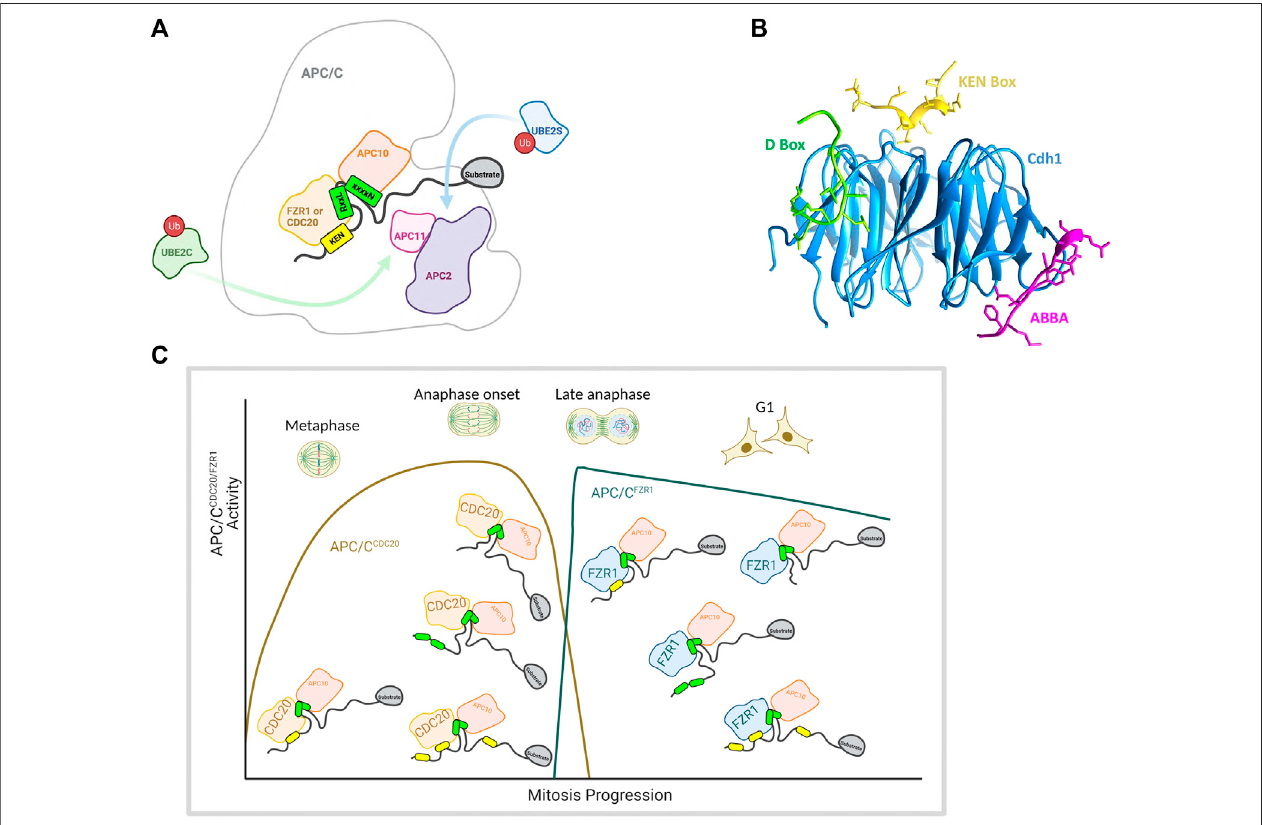
FIGURE 4 | (A) Illustration of the cross section of the APC/C showing key subunits including the coactivator subunit (CDC20/FZR1), D-box co-receptor APC10, ubiquitin-bound E2s (UBE2C and UBE2S), catalytic subunits (APC2 and APC11) and a bound model substrate containing a KEN box and a D-box. (B) Structure of the three degrons (KEN (yellow), D-box (green) and ABBA (pink)) from APC/C-Cdh1 modulator 1 (Acm1) bound to S. cerevisiae APC/C activator protein Cdh1 (blue). The model was made in Chimera (https://www.rbvi.ucsf.edu/chimera) using PDB:4BH6 (He et al., 2013). (C) Schematic showing key APC/C subunits including coactivator subunit, E2 binding positions, and a bound model multivalent substrate containing a KEN box and a D-box Schematic showing proposed changes in substrate valencies during mitotic exit. D-boxes indicated in green, KEN motifs in yellow, Schematics were created with BioRender.com.